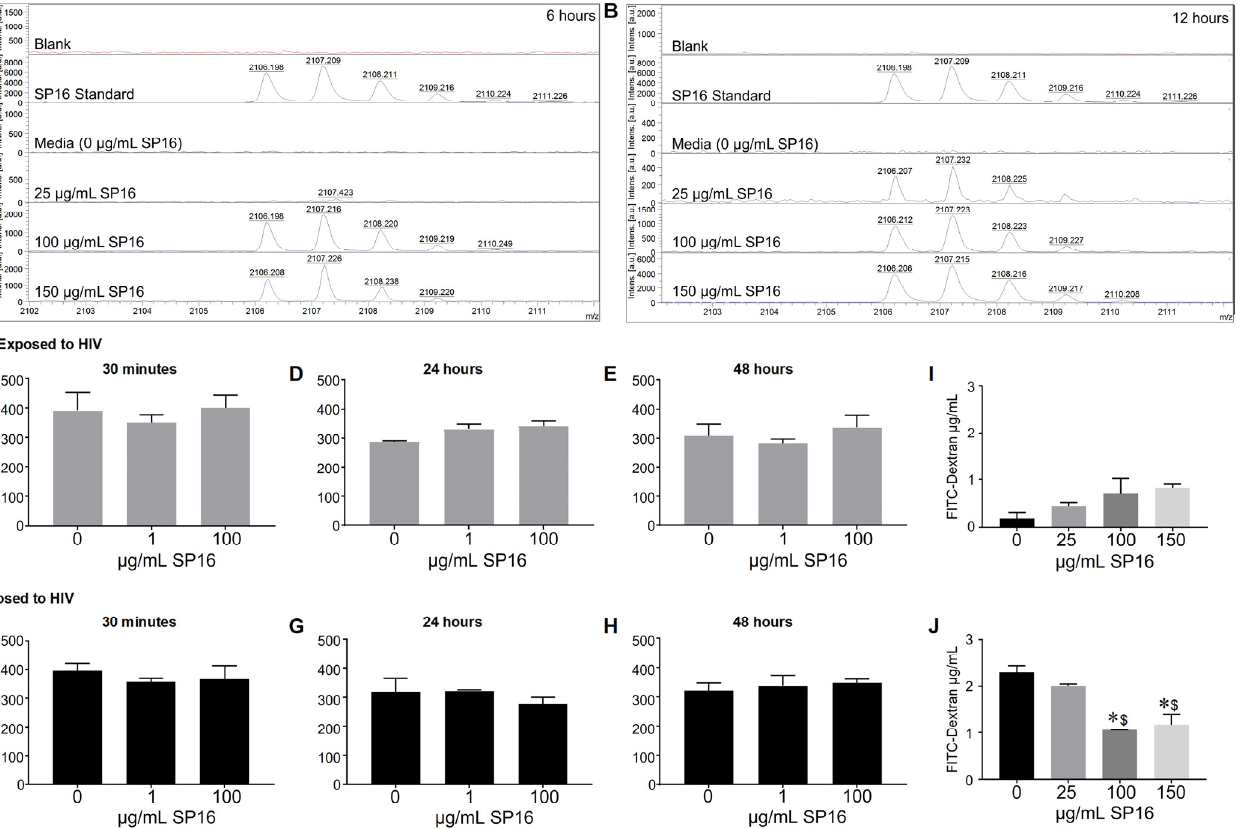
Figure 2. Movement of SP16 across an artificial blood-brain barrier (BBB). Supernatant was collected after 6 h ( A ) and 12 h ( B ). MALDI-TOF-MS analysis was conducted on the Burker AutoFlex III instrument to test the transportation of different SP16 concentrations across the BBB at the indicated time points. Integrity of the BBB was measured using a Millicell ERS microelectrode ( C – H ) and by a FITC-dextran Assay ( I , J ). Results are reported as the mean ± SEM of 3 independent experiments. Data was analyzed using one or two-way ANOVA analysis followed by Dunnett multiple comparisons A value of p < 0.05 was considered significant. * vs. media; $ vs. 25 μ g/mL SP16.